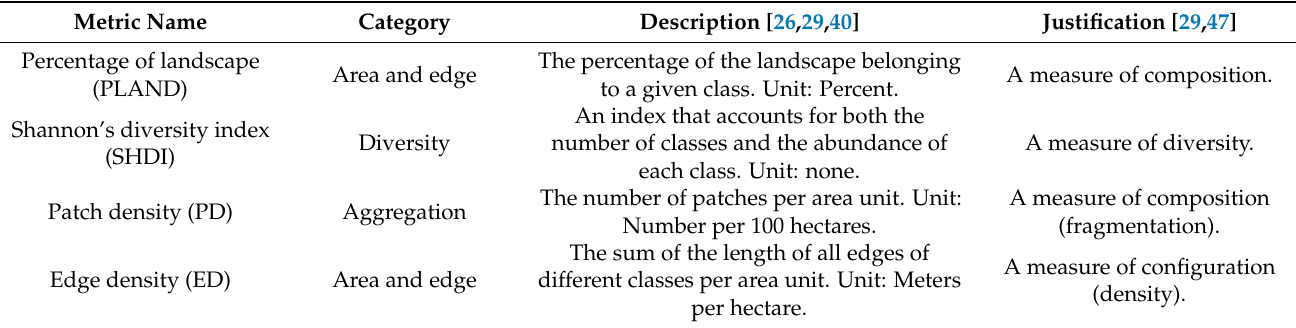
Table 1. Selected landscape